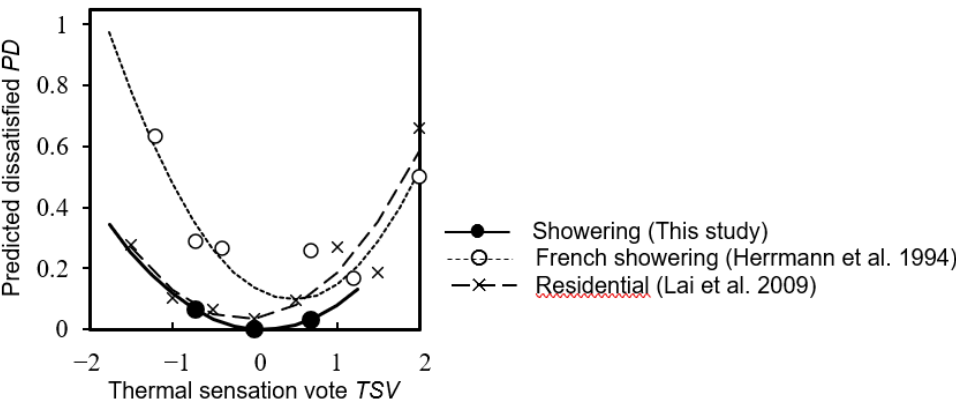
Figure 5. Predicted dissatisfied PD ; the values reported by Herrmann et al. [9] and by Lai et al. [16] are shown for comparison.